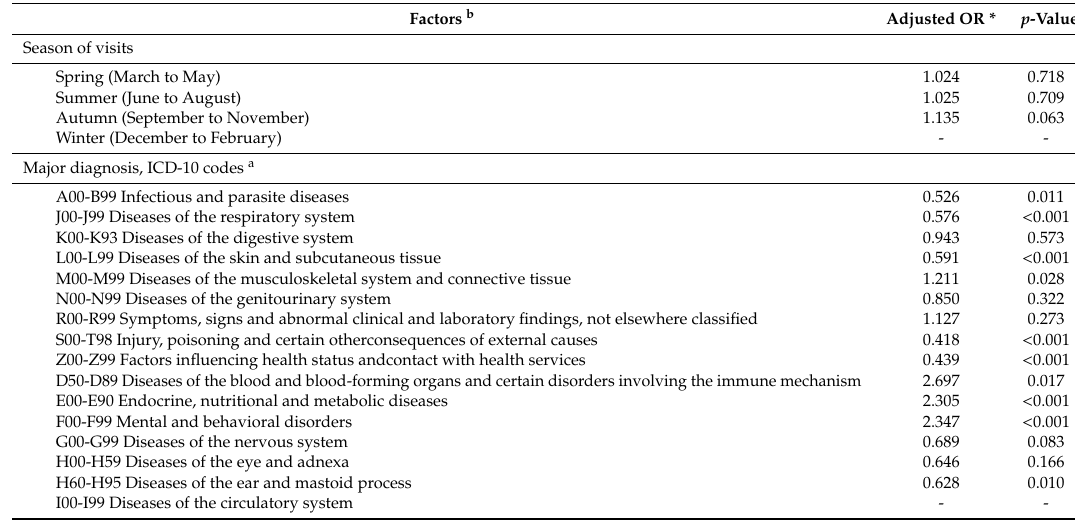
Table 4. Comparison of factors between FAs and NFAs under multivariate regression